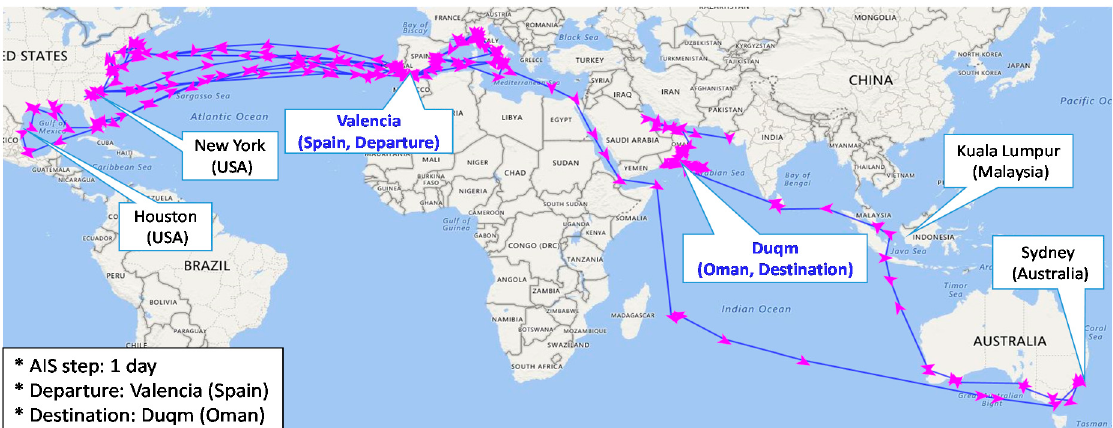
Figure 5. Trajectory analysis of a container ship.